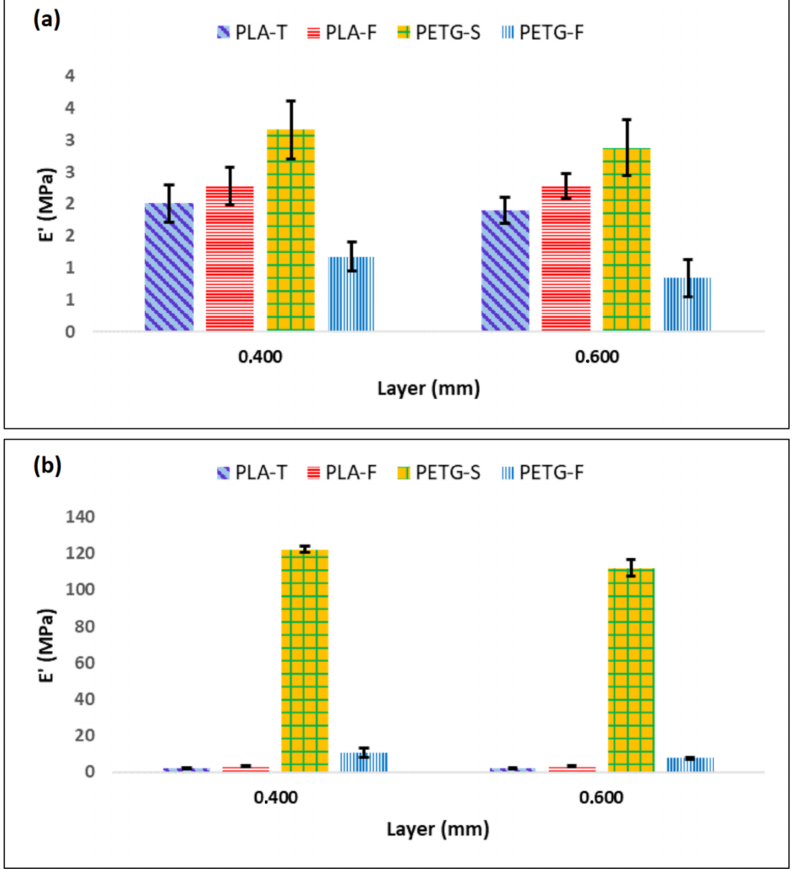
Figure 9. Results of the impact strength in Charpy impact tests on the V-notched specimens of 3D-printed PETG and PLA samples in ( a ) (1,0,0) and ( b ) (0,0,1) fibre